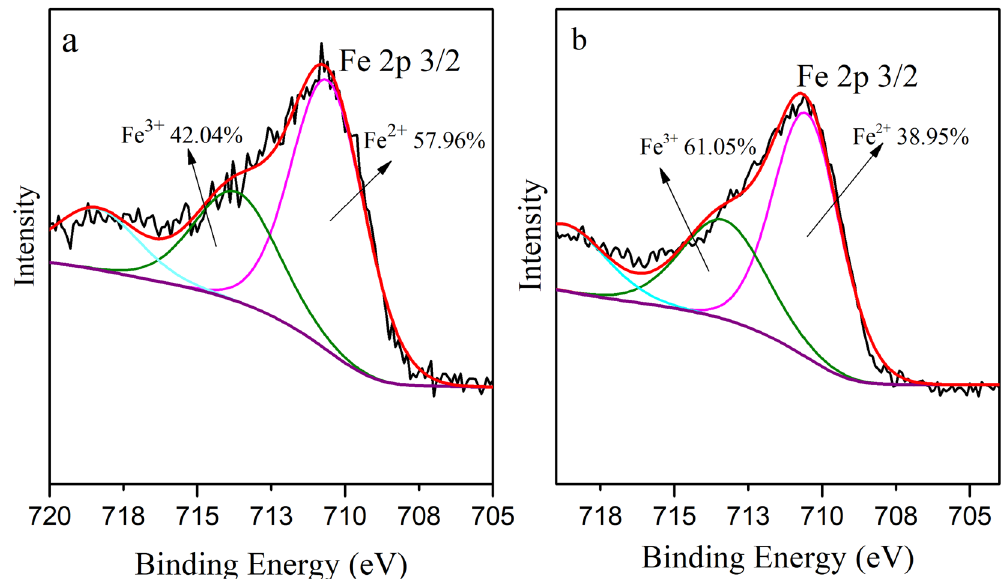
Figure 9. Fe 2p 3/2 XPS peak differentiation-imitating analysis of the electrode particles (AC-Fe) ( a ) before and ( b ) after the EKR